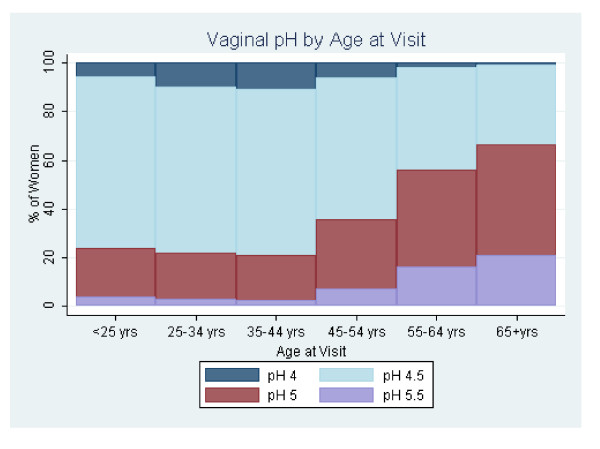
The percentage of women with a given pH measurement (4.0, 4.5, 5.0, or 5.5) stratified by age at visit.